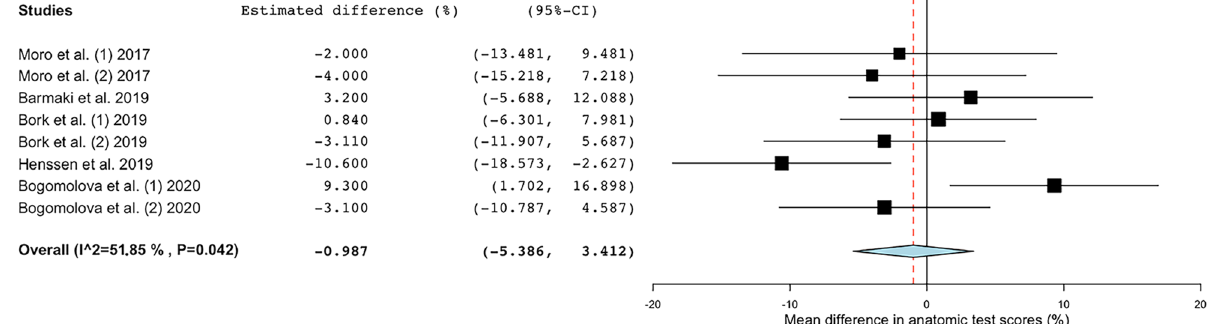
Figure 2. Forest plot showing the estimated mean difference in anatomic test scores (%) from the different included studies investigating AR as compared with other forms of anatomical education. AR augmented reality, 95%-CI 95%-confidence interval.